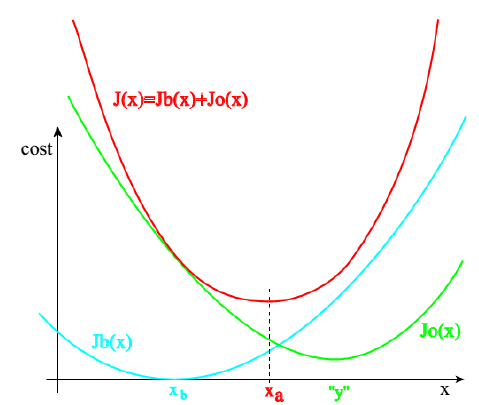
Figure 3. Schematic shows a cost function and minimization process. Figure from [Bouttier and Courtier,